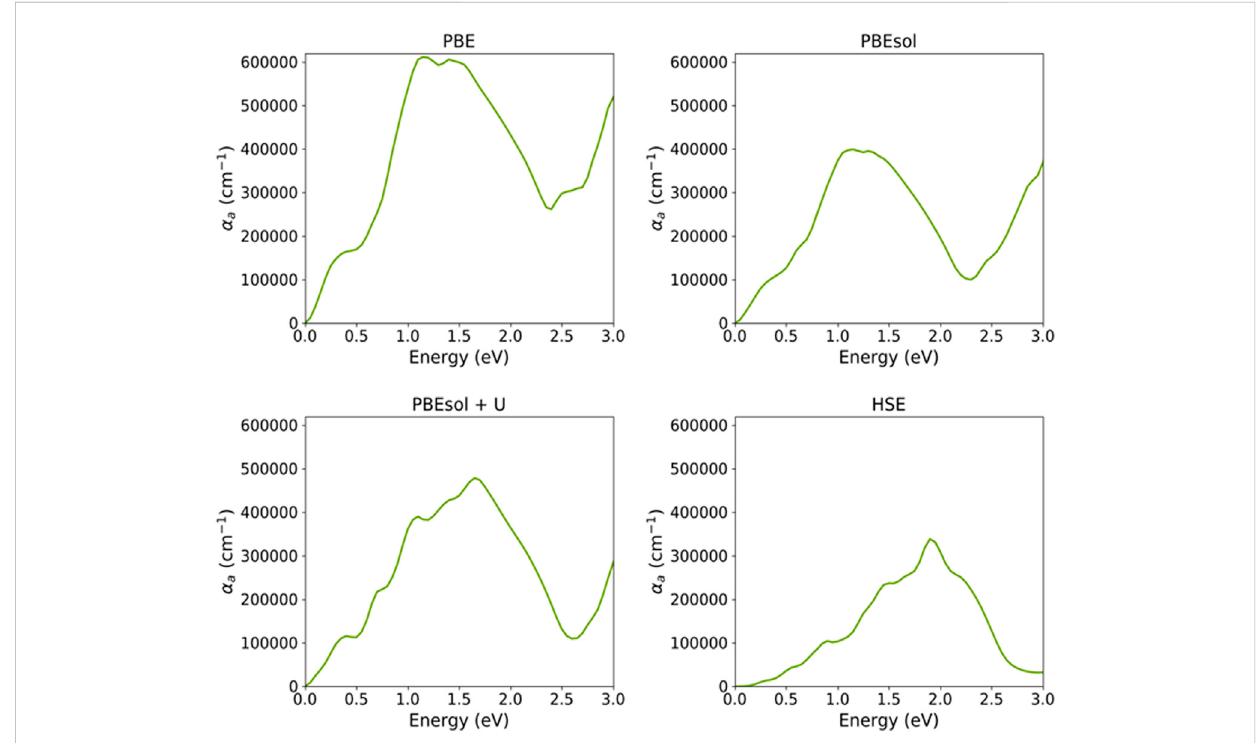
FIGURE 6 Optical absorption spectra of the VO 2 (M) polymorph, as a function of energy (eV), predicted by the PBE, PBEsol, PBEsol + U, and HSE functionals.